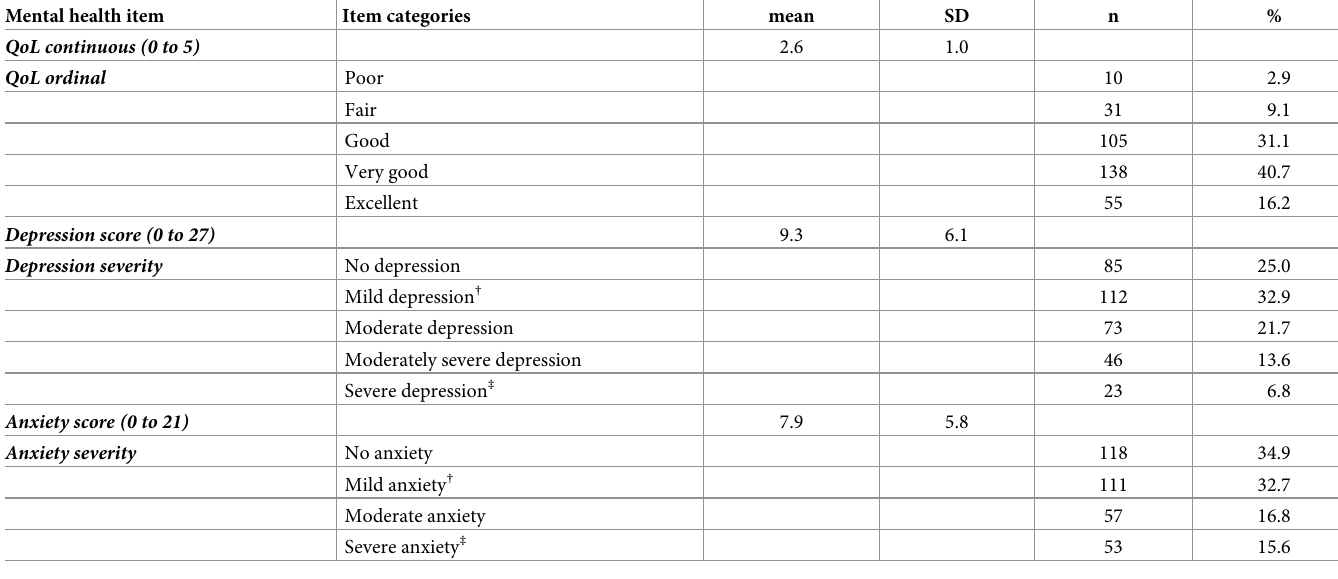
component was positively associated with QoL ( β = .20, p � .001). The junk food component was positively associated with depression ( β = .26, p � .001), while the animal food component and the plant food component were negatively associated with depression ( β = -.07, p � .05 and β = -.10, p � .001, respectively). The junk food component was further positively associated with anxiety ( β = .18, p = .001) and the animal food component was negatively associated with anxiety ( β = -.09, p � .001). Table 5 shows the detailed results for the unadjusted associations between the main explanatory variable of interest (dietary pattern) and QoL, depression, and anxiety, respectively. After adjusting for all covariables, the positive associations between the junk food compo- nent and depression and anxiety remain significant. Model 1 (dietary pattern and QoL): After adjusting for all covariables, statistically signifi- cant negative associations were found between Asian ethnicity, stress, and QoL; significant positive associations were found for physical activity, weight satisfaction, and social support with QoL. Social support showed the strongest positive association for QoL ( β = .51 increase in QoL score; p � .001). Table 4. Mental health and wellbeing. Mental health